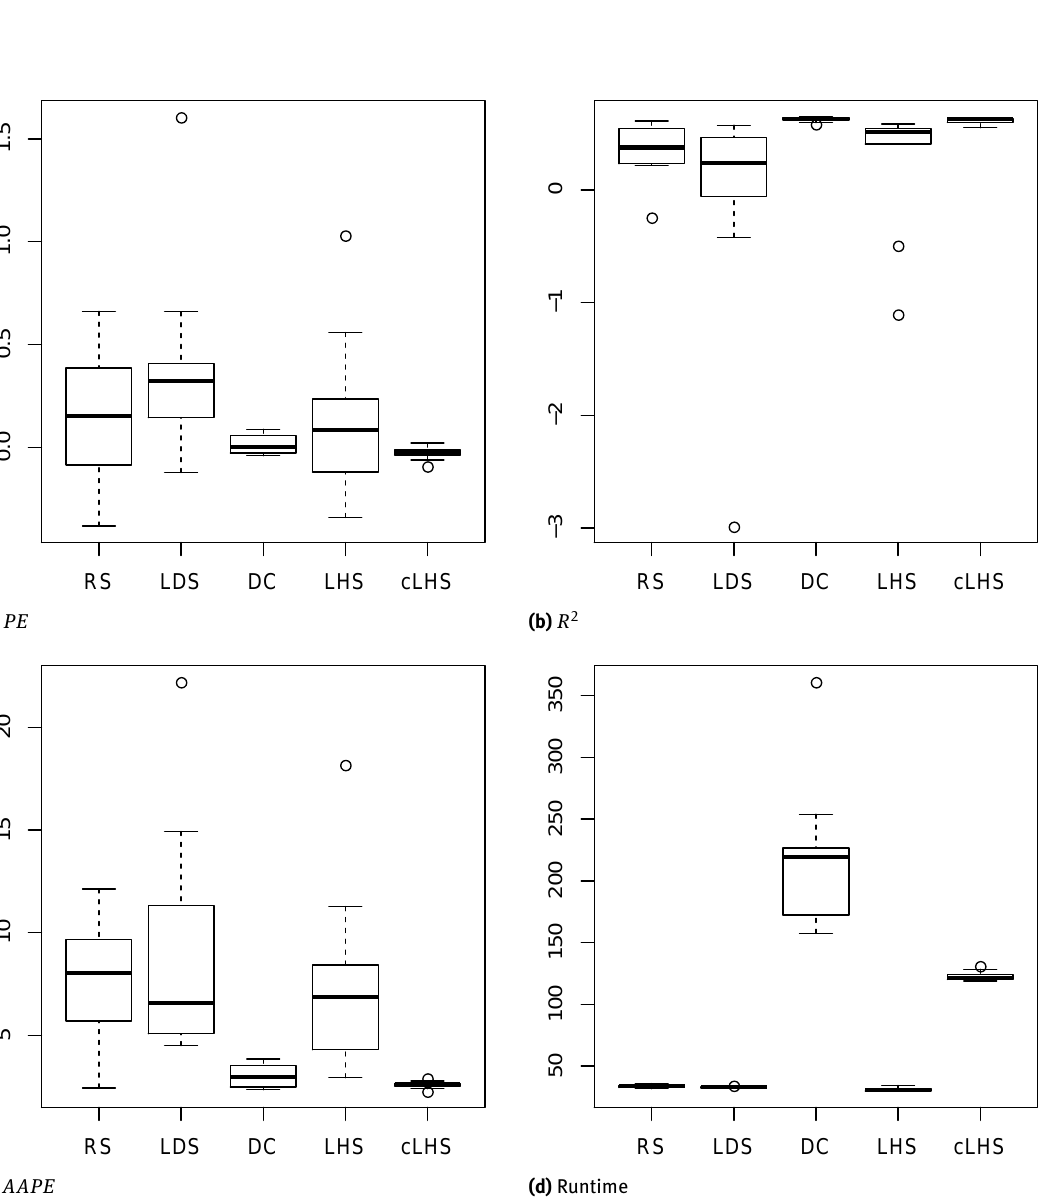
Figure 6: Box plots of the performance measures from 10 runs of the experimental design methods when s = 880